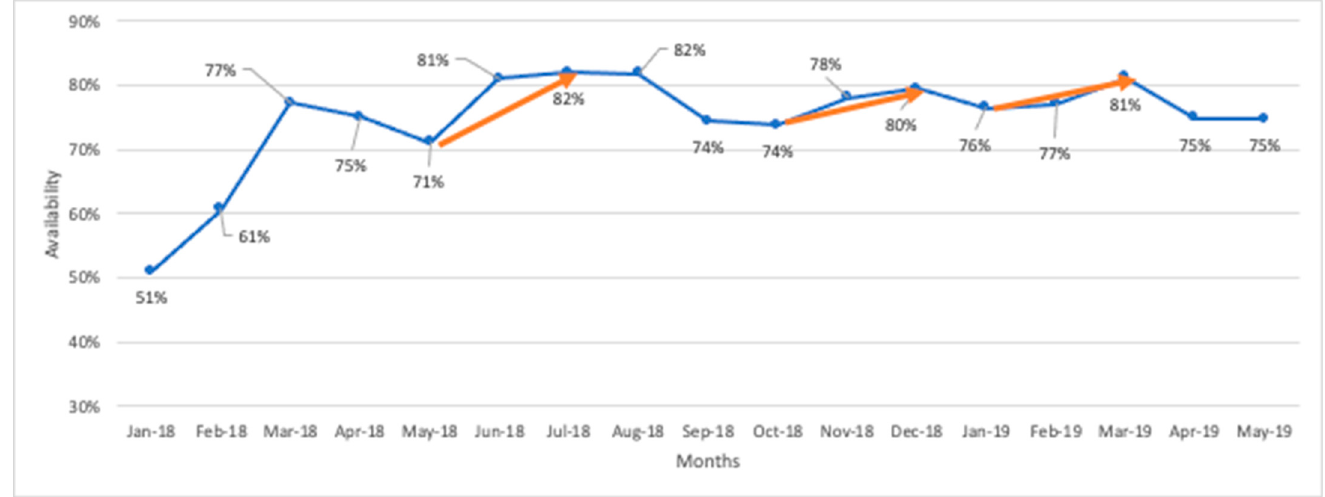
Figure 5. Availability time series.